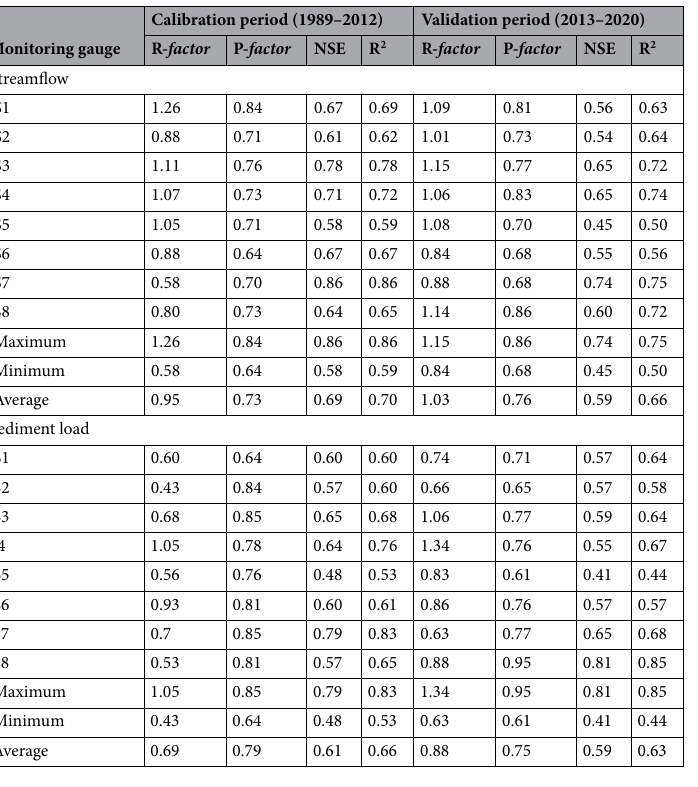
Table 3. Statistical performance of the SWAT model for calibration and validation